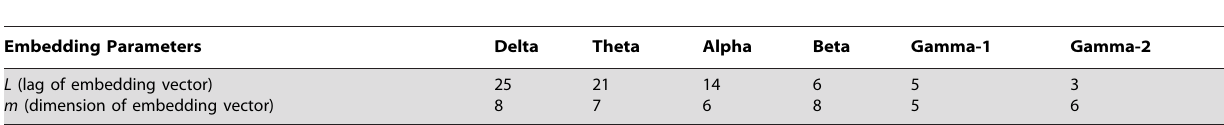
Table 1. The synchronization likelihood parameters for six frequency bands which were used for calculating the TFSL .